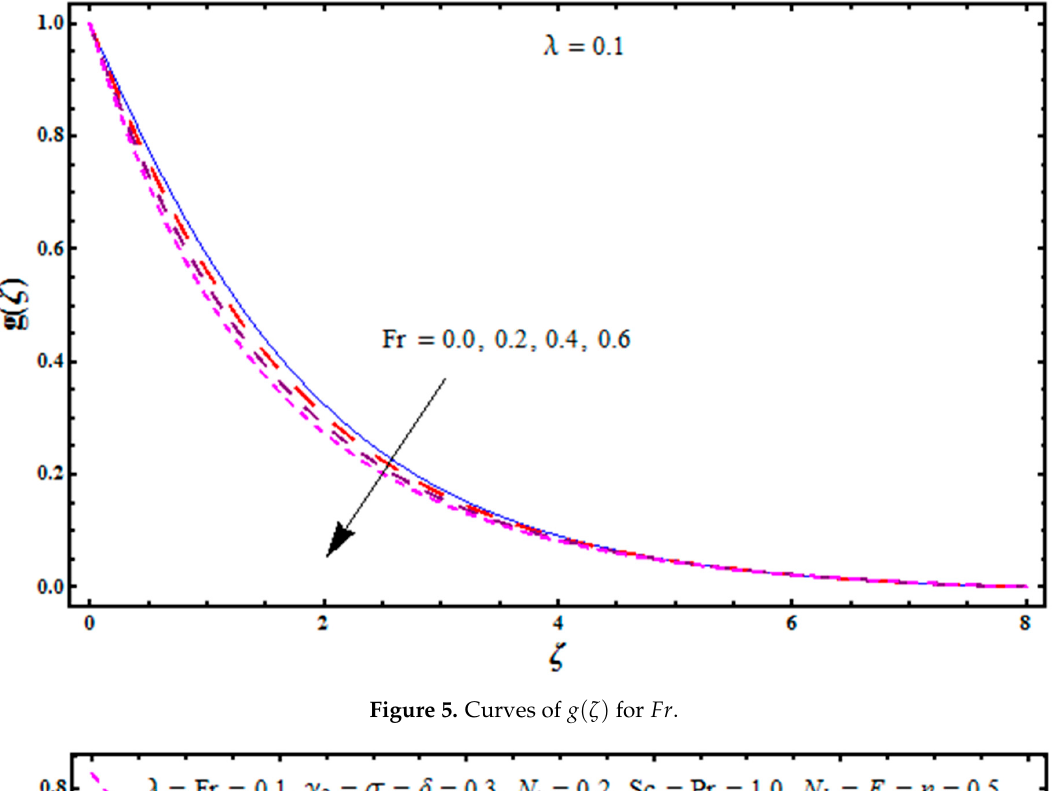
Figure 5. Curves of g ( ζ ) for Fr .